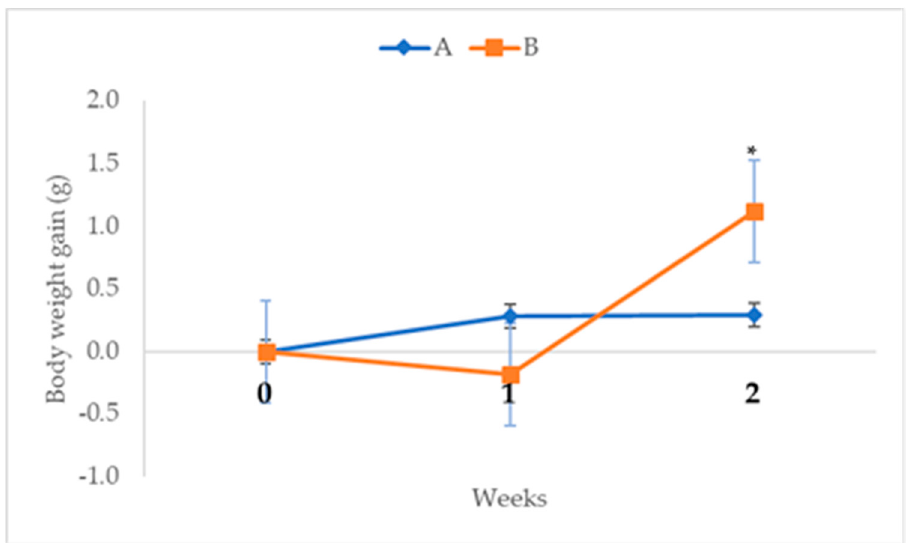
Figure 10. Weekly body weight gain (g) of female ICR mice in acute toxicity study of CELE. Key: CELE = Clinacanthus nutans ethanolic leaf extract, A = control, B = 2000 mg/kg CELE, * = significantly different at p < 0.05.